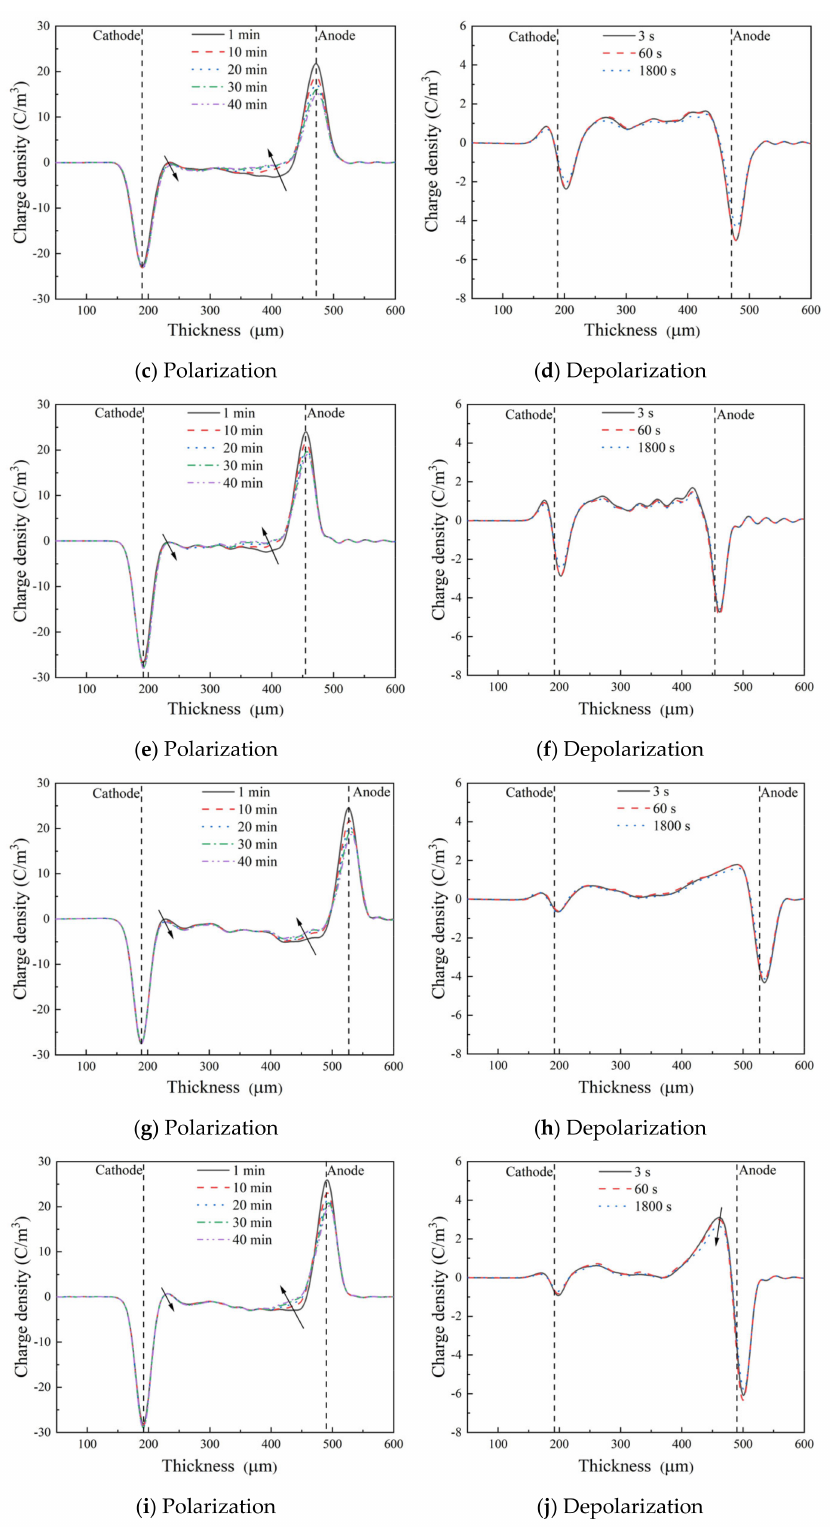
Figure 4. Space charge distributions of XLPE and HVA-2 grafted XLPE; ( a , b ) corresponding to XLPE, ( c , d ) to XLPE-g-0.3HVA, ( e , f ) to XLPE-g-0.5HVA, ( g , h ) to XLPE-g-1.0HVA, and ( i , j ) to